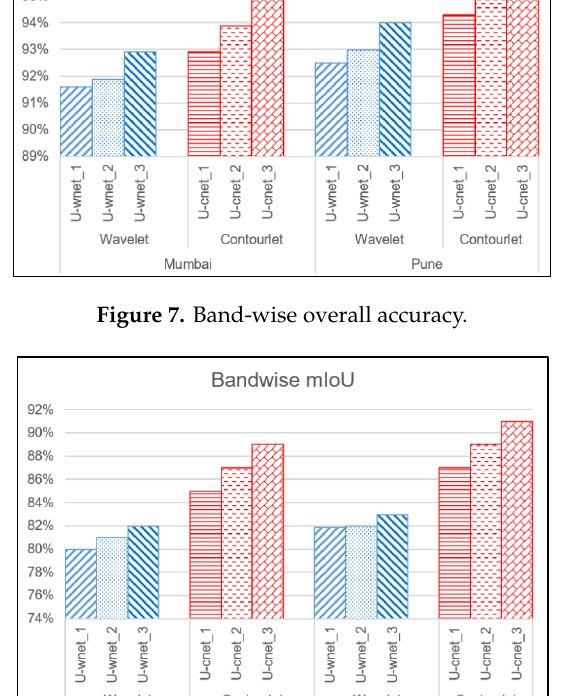
Figure 8. Band-wise mean intersection over union (mIoU).